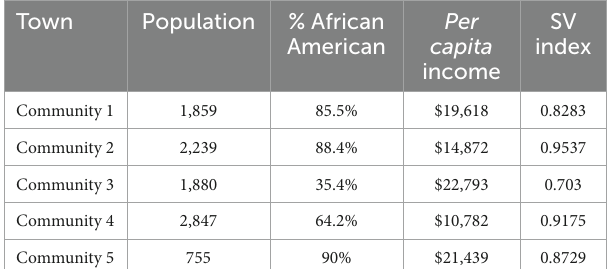
TABLE 1 Community